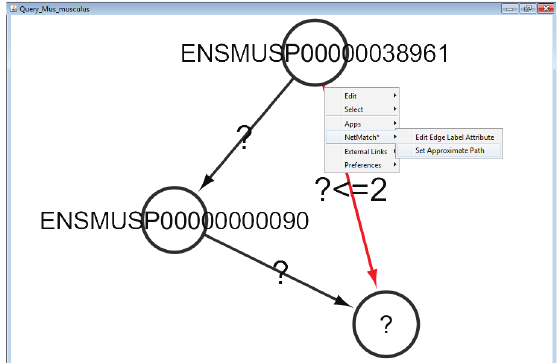
Figure 4. Panel for the creation of a query network in NetMatchStar. In this example, an approximate query with 3 nodes and 3 edges has been created, where 2 nodes have a specific label and one edge represents an approximate path of length at most 2 (’?<=2’). The remaining elements of the graph have an unspecified label (’?’). By selecting an edge and right- clicking, a menu will be shown for changing its label or set the approximate